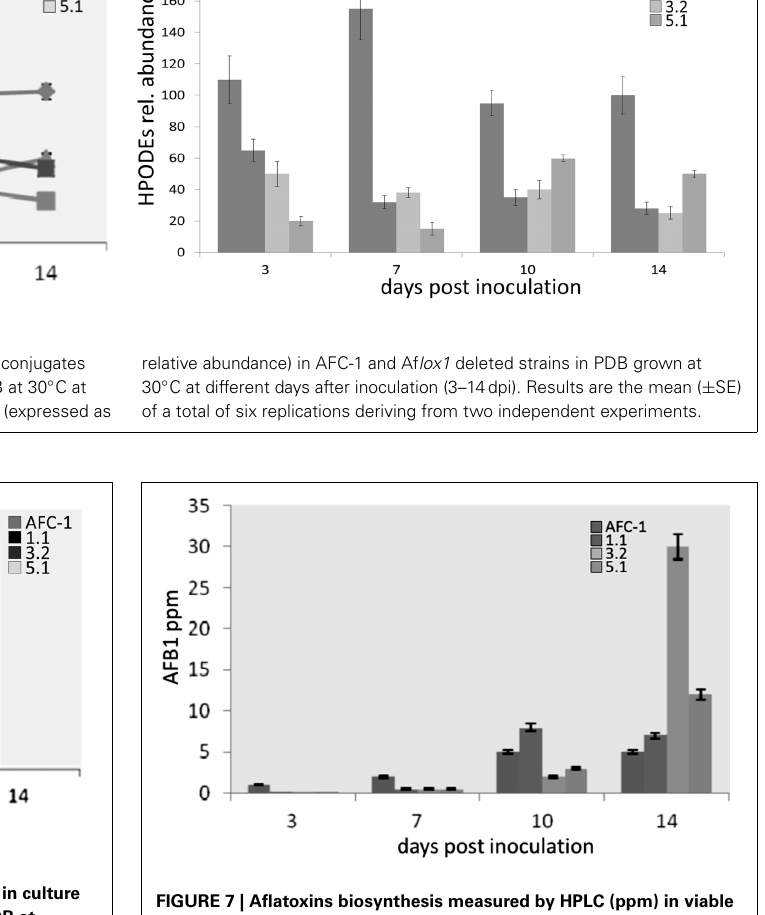
FIGURE 7 | Aflatoxins biosynthesis measured by HPLC (ppm) in viable seeds of maize by AFC-1, Af lox1 (cid:2) _ 1.1, Af lox1 (cid:2) _ 3.2, and Af lox1 (cid:2) _ 5.1 strains incubated at 30 ◦ C for different days post inoculation (3–14dpi). Results are the mean ( ± SE) of a total of six replications deriving from two independent